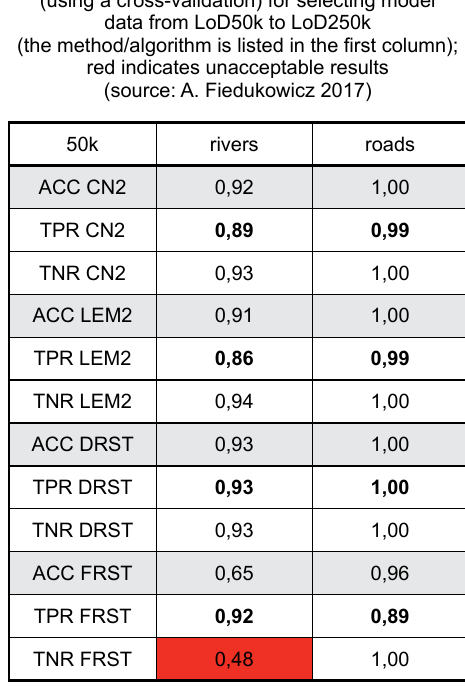
Table 2. Averaged results (using a cross-validation) for selecting model data from a scale level